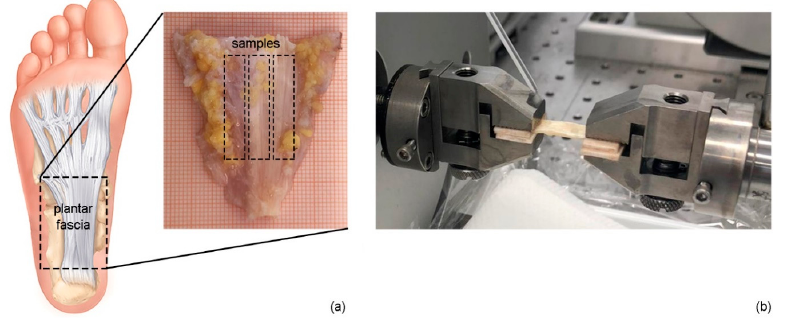
Figure 1. Portion of dissected Plantar Fascia (PF) from midfoot region and disposition of samples cut along the fiber di- rection ( a ); lateral view of gripped PF sample under mechanical testing ( b ).